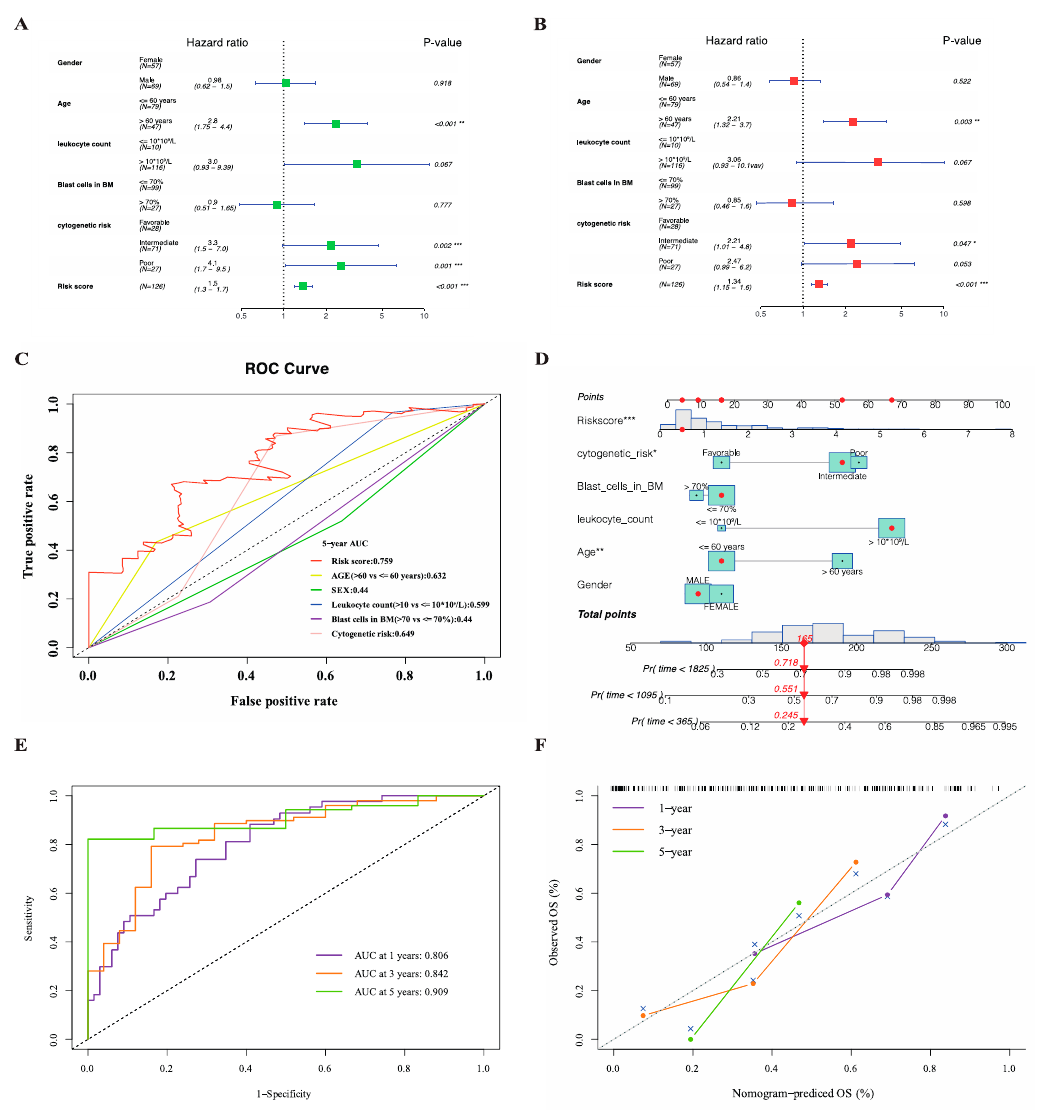
Figure 9. Construction of the OS-predictive nomogram for clinical application in TCGA cohort. ( A , B ) Univariate ( A ) and multivariate ( B ) Cox regression analysis of the risk signature to verify its independent predictive efficacy of OS. ( C ) ROC curves for the risk score and major clinical features including gender, age, white blood cell (WBC) count, blast cells percentage in bone marrow (BM) and cytogenetic risk. ( D ) Nomogram based on the combination of clinical features and risk score predicting 1-year, 3-year and 5-year survival. ( E ) ROC curves showing the predictive power of nomogram. ( F ) Calibration plot showing the predictive reliability of nomogram. p values are showed as: * p < 0.05; ** p < 0.01; *** p < 0.001.